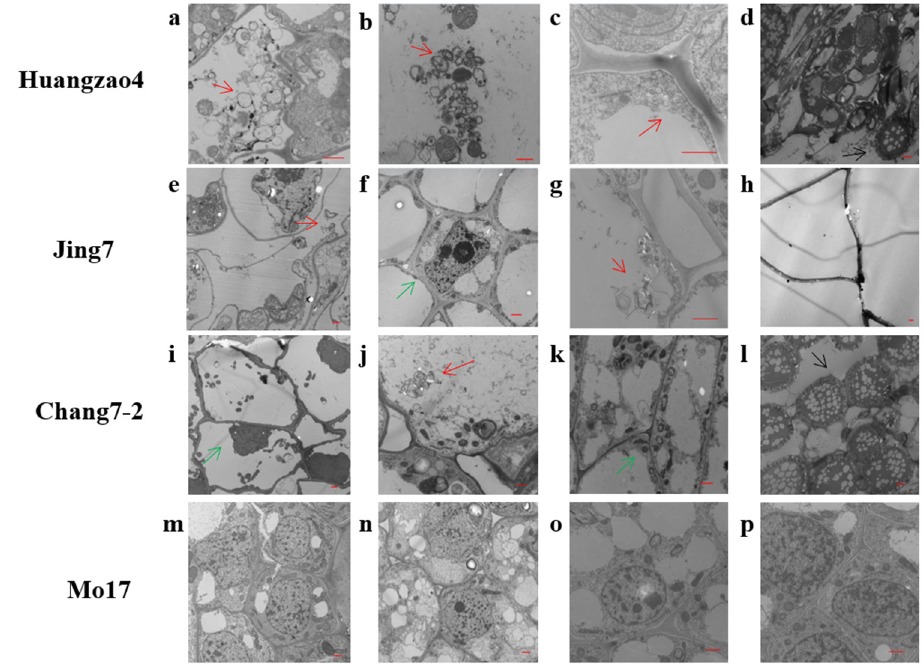
Figure 1. Cell structure analysis of three typical maize inbred lines and the resistant inbred line Mo17 at different growth stages. ( a – d ) Cells from Huangzao4 growth points or tassels after inoculation at the VE, V8, V12, and VT stages, respectively. ( e – h ) Cells from Jing7 growth points or tassels after inoculation at the VE, V8, V12, and VT stages, respectively. ( i – l ) Cells from Chang7-2 growth points or tassels after inoculation at the VE, V8, V12, and VT stages, respectively. ( m – p ) Cells from Mo17 growth points or tassels after inoculation at the VE, V8, V12, and VT stages, respectively. The ”-”scale is 1 μ m. The red arrow indicates cell autophagy; the green arrow indicates plasmolysis.